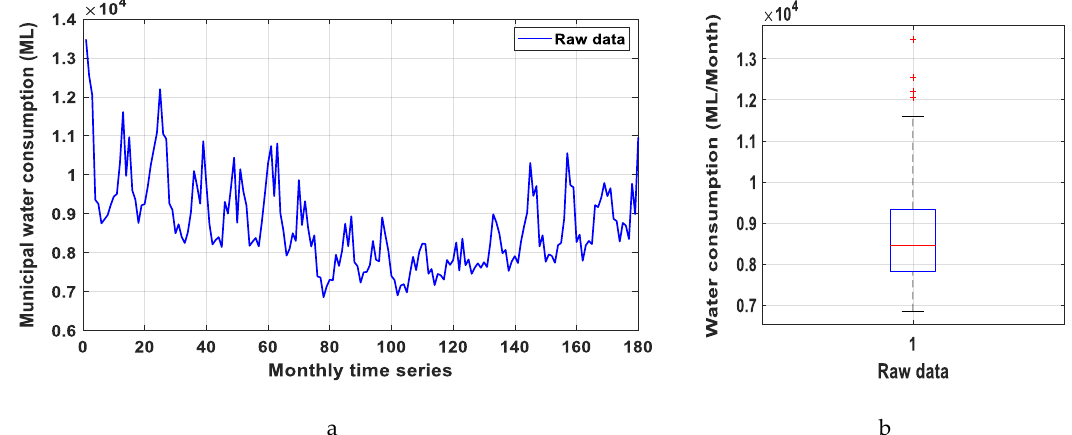
Figure1. UrbanwaterconsumptionforCityWestWater(CWW)utility,( a )Monthlytimeseries,( b )Boxplot. Figure 1. Urban water consumption for City West Water (CWW) utility, A) Monthly time series, B) Box plot.